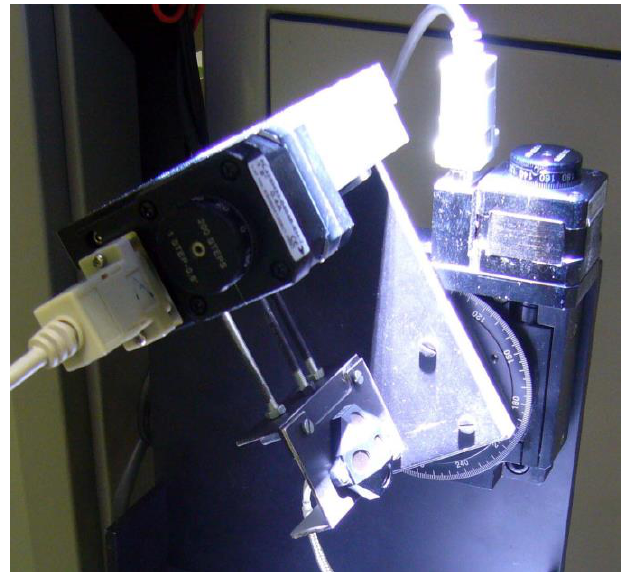
Figure 10. Experimental setup to evaluate Sun sensor drivers. In this case the Sun sensor is suffering shadow and albedo effect. shadow and albedo